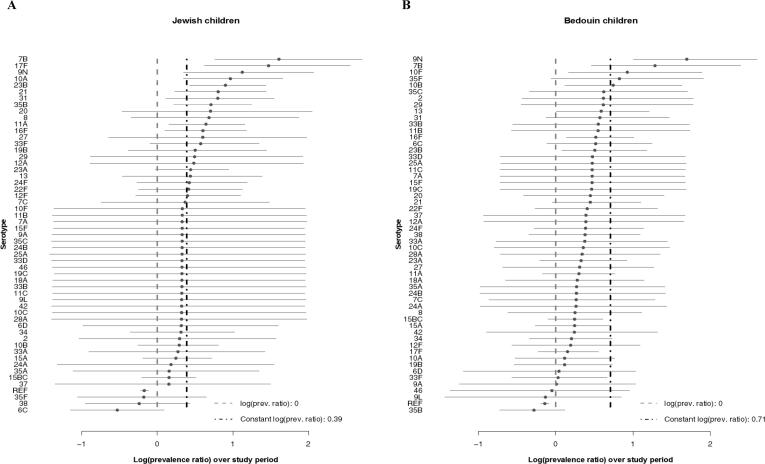
Log(prevalence ratios) from the carriage models for children under 5 in Israel, November 2009-June 2016. Log-transformed ratios comparing late post- to pre-vaccine prevalence (last year/first year) are shown for each serotype with 95% credible intervals from the Jewish (A) and Bedouin (B) carriage models. The serotypes are shown from highest to lowest log prevalence ratios.